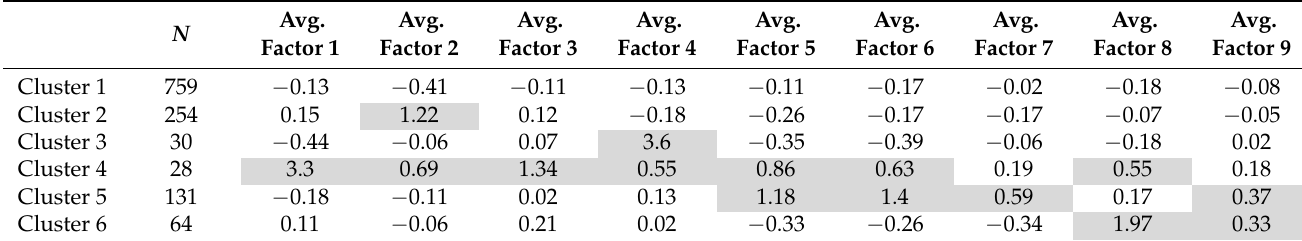
Table 4. Average of each cluster.